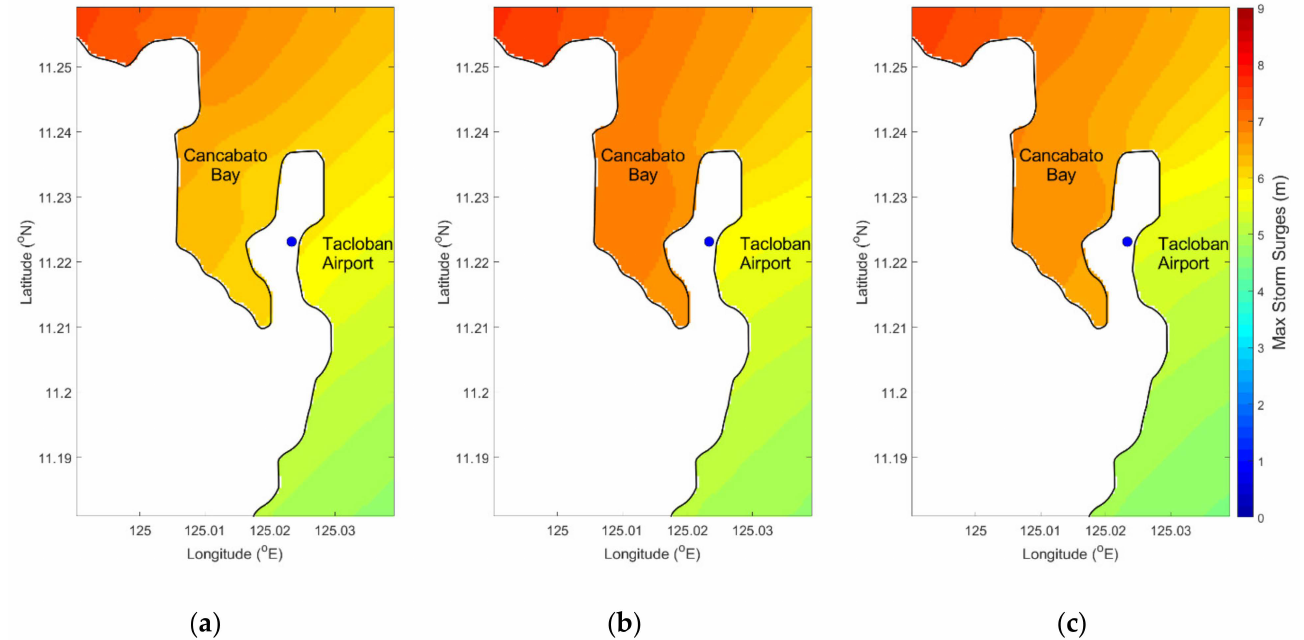
Figure 15. Maximum storm surges of the ( a ) nonlinear equation model with the moving shoreline; ( b ) nonlinear equation model with the fixed shoreline; and ( c ) linear equation with the fixed shoreline. The color shading indicates the maximum storm surges in m. The solid black line shows the shoreline of